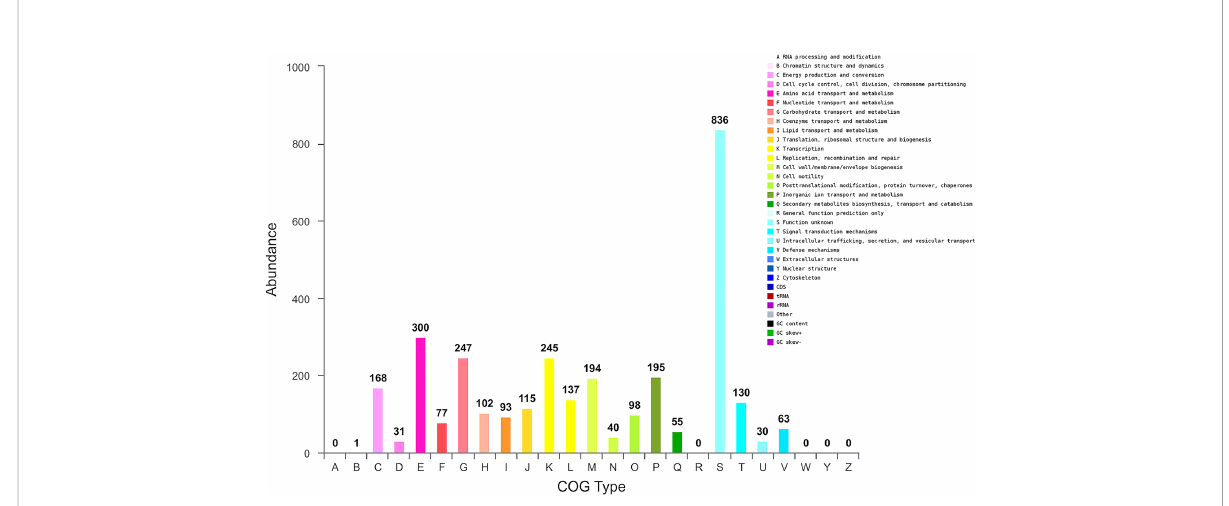
FIGURE 4 Genome sequence analysis of B halotolerans LDFZ001. Gene numbers involved in different pathways.